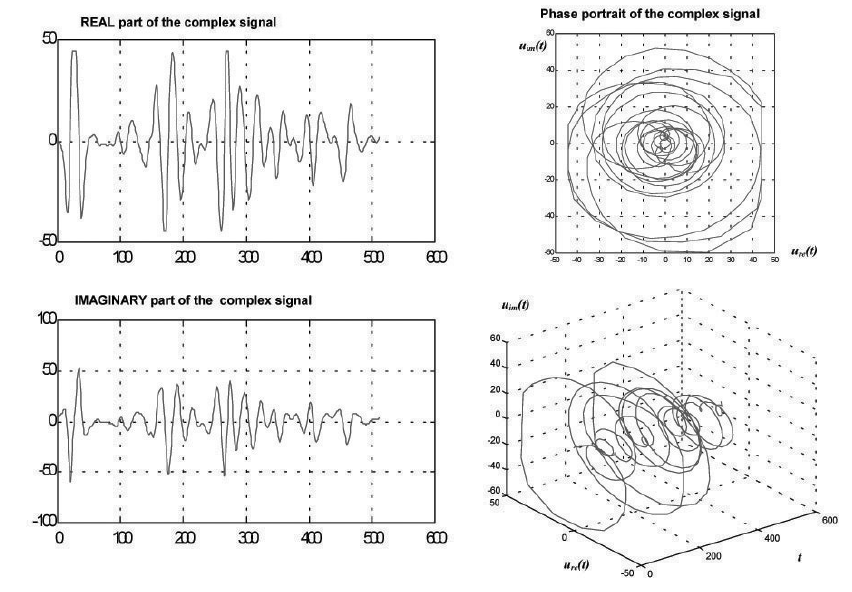
Figure 2. Complex analytical signal in 3D space constructed from real radar sounding signal.